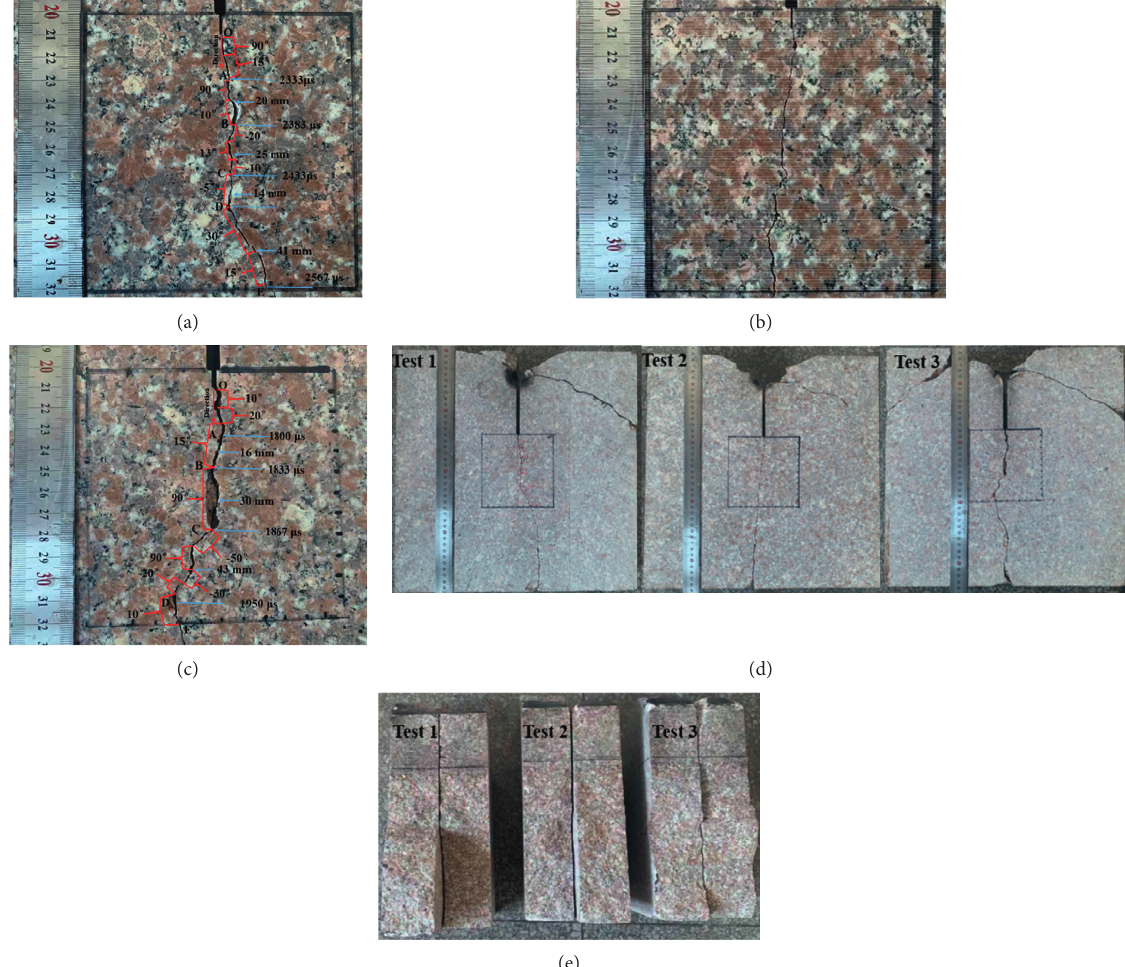
Figure 7: Actual crack and fracture appearance after the explosion. (a) Actual crack in the shooting area for test 1, (b) actual crack in the shooting area for test 2, (c) actual crack in the shooting area for test 3, (d) actual crack, and (e) fracture